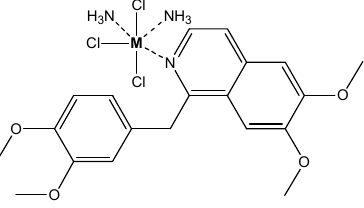
Figure 3. Proposed structure of M(III)–papaverine complex, where M = V(III), Ru(III) or Au(III).